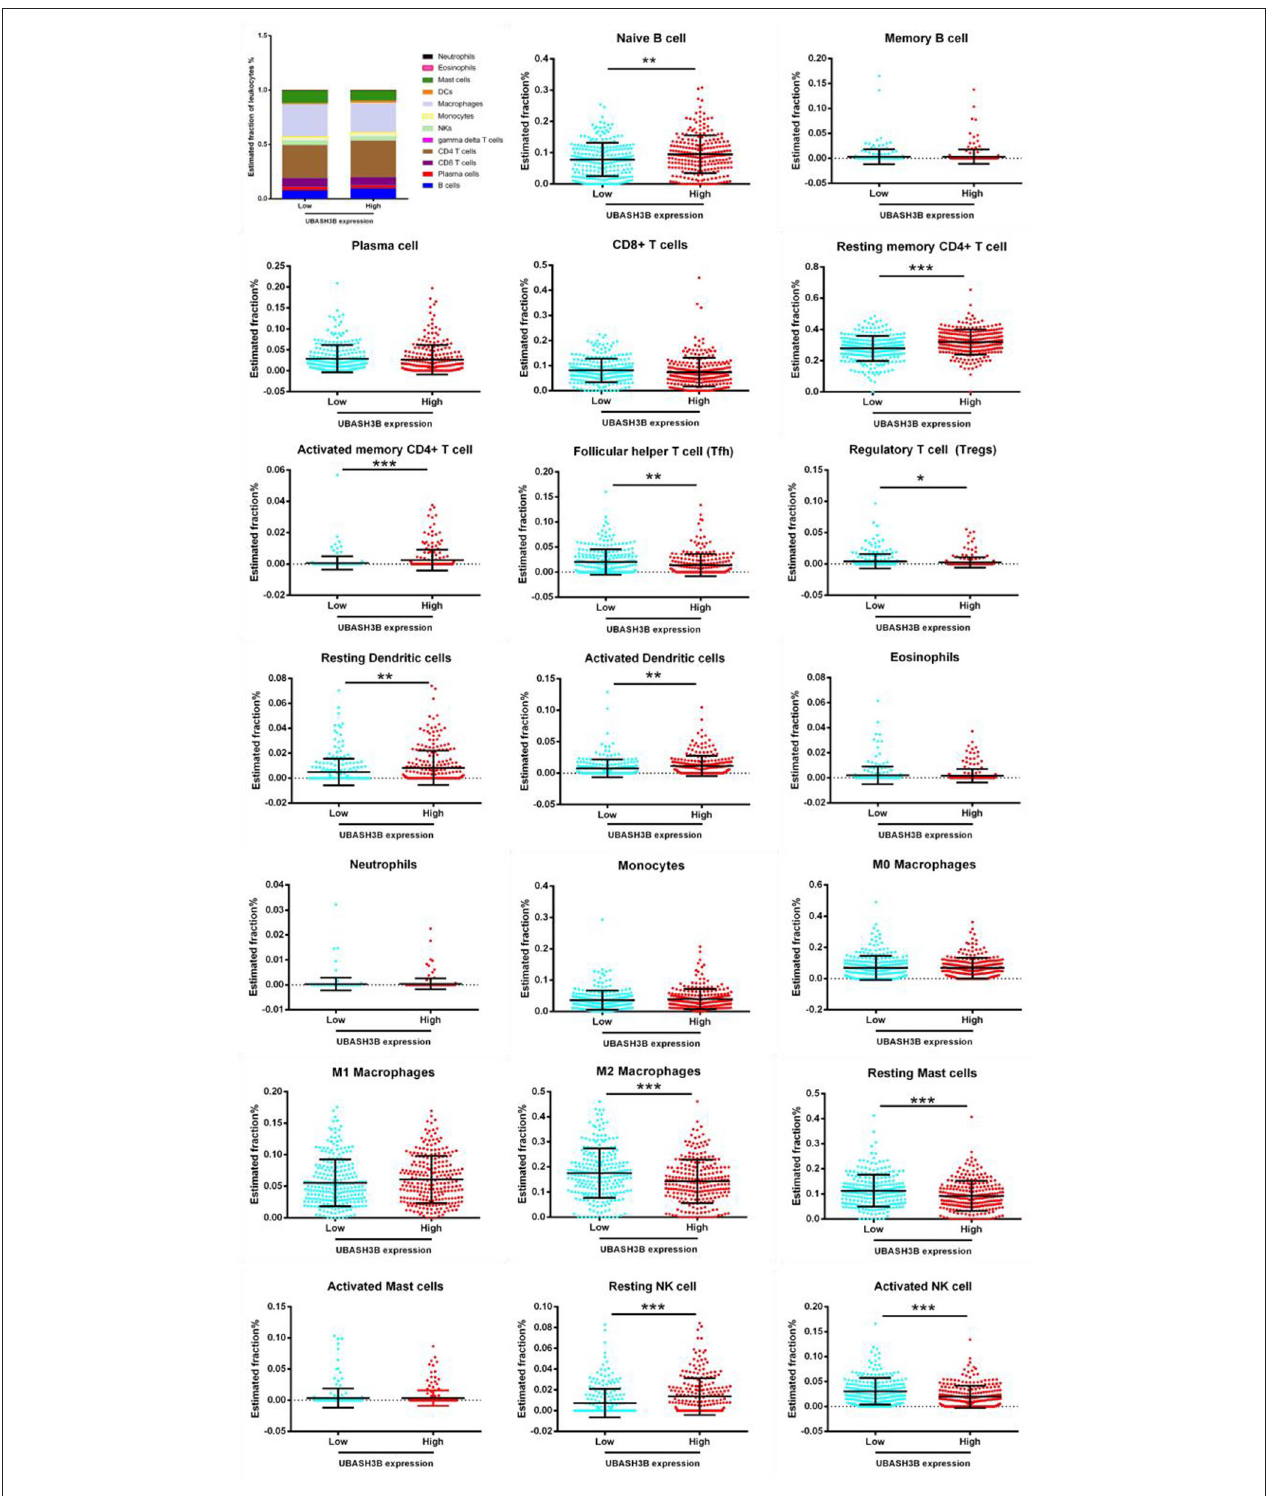
FIGURE 7 | Based on TCGA-PRAD database, LM22 signature matrix is used for analysis using CIBERSORT online. Twenty-two kinds of tumor infiltrating immune cells are plotted according to UBASH3B expression level. There are significant differences in naïve B cell, memory B cells, resting CD4 + memory T cell, activated CD4 + memory T cell, regulatory T cell, activated NK cell, M2 macrophages, resting dendritic cells, activated dendritic cells, resting mast cells, neutrophils (*** < 0.001 < ** < 0.01 < * < 0.05).